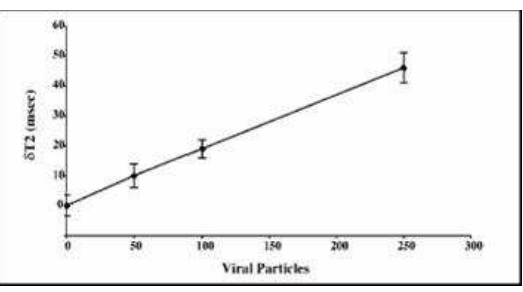
Figure 13. d T2 as a function of virus particle concentration ( Reprinted from [28] with permission from ACS ).